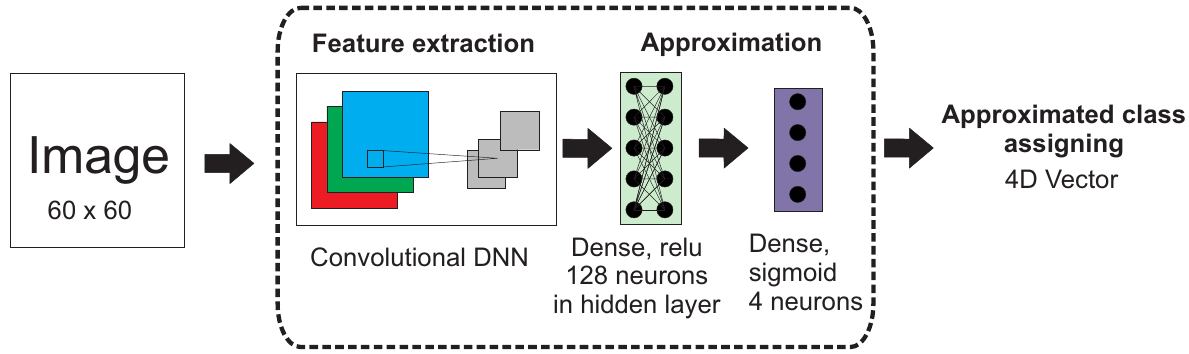
Figure 2. The architecture of the proposed deep convolutional neural network for uncertain class